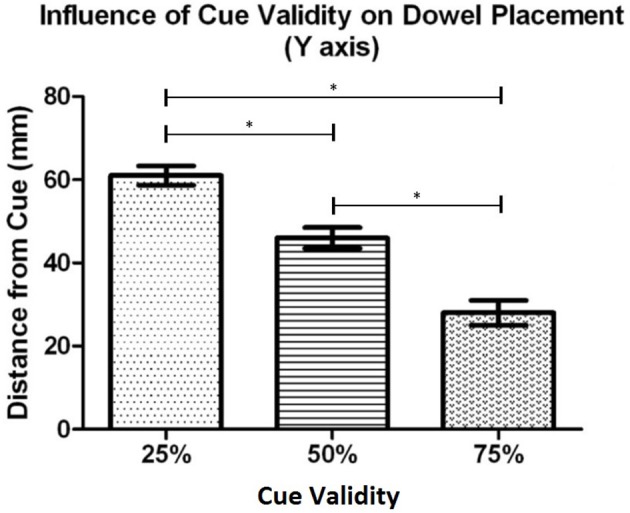
Experiment 2: Mean dowel placement relative to the cued location as a function of cue validity. Error bars represent the standard error of the mean. The * indicates a statistically significant difference.